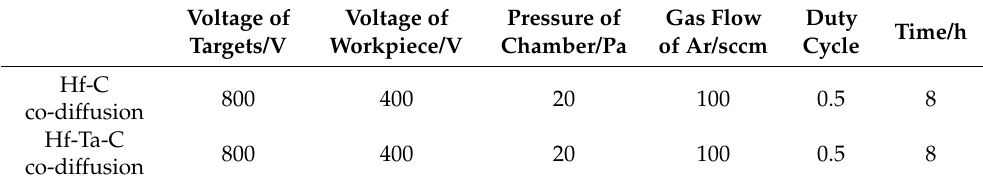
Figure 1. Schematic representation of DG technology. Table 1. The specific experimental parameters of DG.